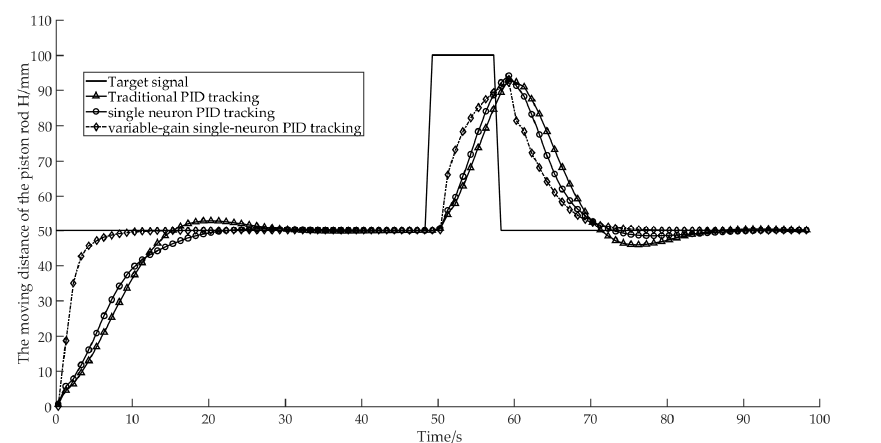
Figure 10. Comparison of simulations of lifting signal tracking under different control algorithms.